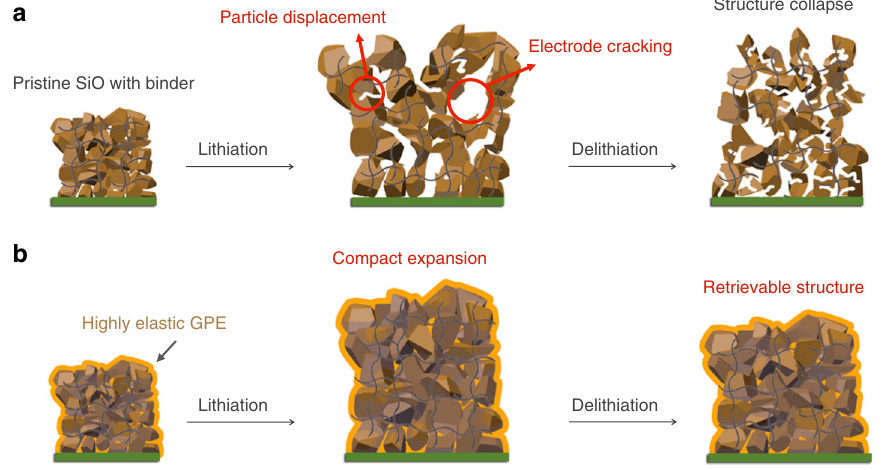
Fig. 1 Schematic illustration of an elastic gel polymer electrolyte (GPE)-incorporated SiO anode with a reliable electrode structure. a Severe structural collapse of a conventional SiO electrode during lithiation and delithiation. The huge volume changes of SiO particles lead to the cracking at the particle level and electrode level. The blue lines represent the electrode binder. b The integrated structure of a SiO electrode during cycling enabled by a supremely elastic GPE, which serves as an intra-electrode cushion (orange) to reduce the thickness increase and cracking during lithiation and to help retrieve the electrode structure during